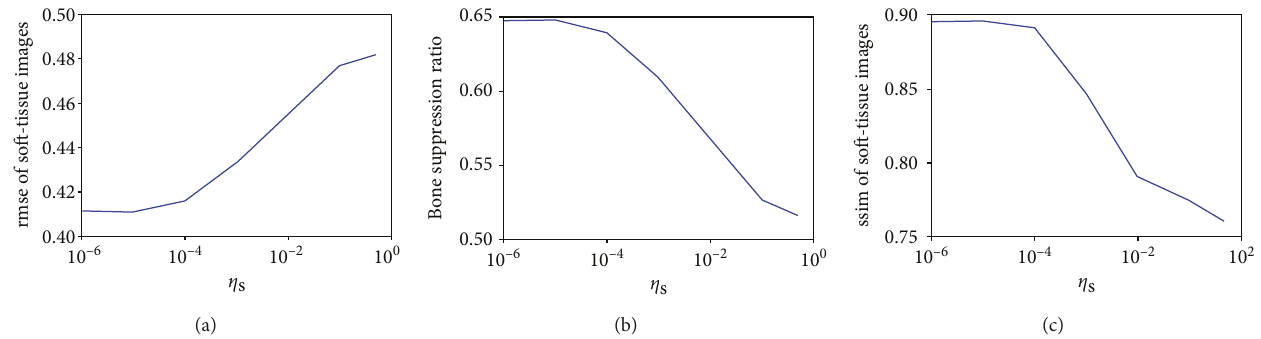
Figure 5: The e ff ect on decomposition performance of parameter η